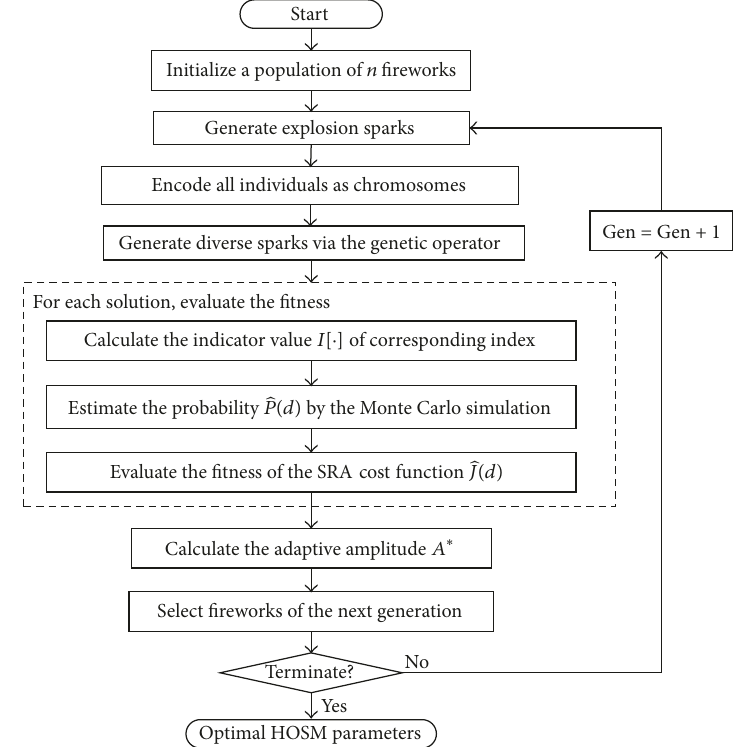
Figure 8: Flowchart of the hybrid FWA-based parameter optimization method.